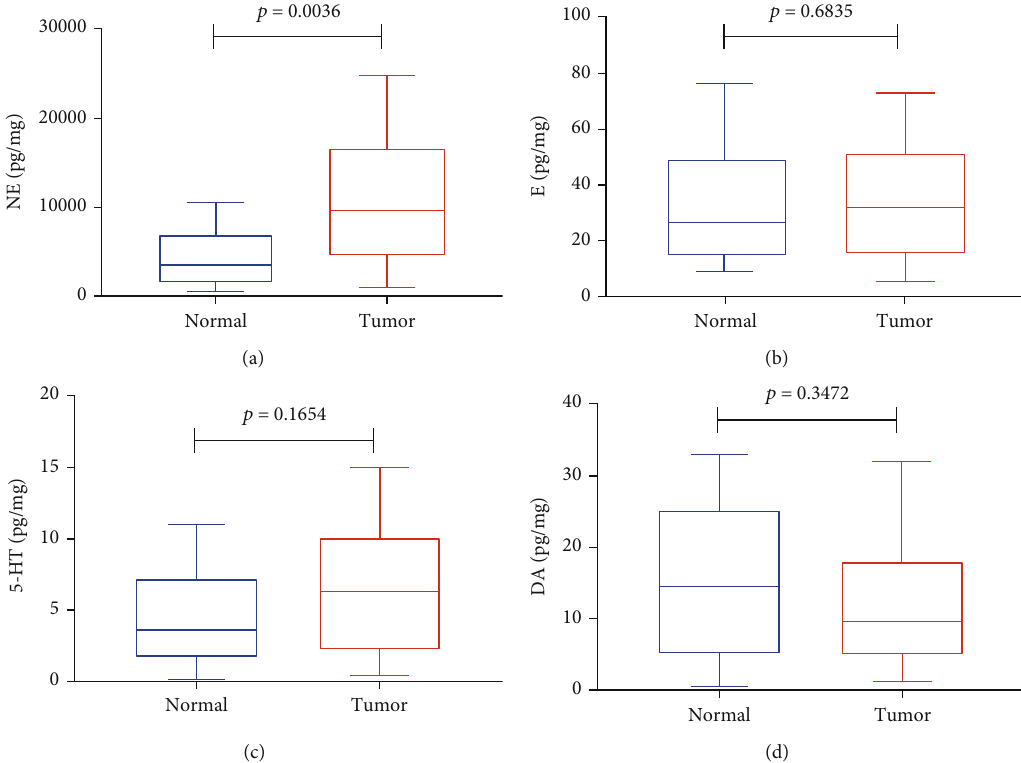
Figure 1: NE is more highly expressed in gastric tumor tissue than in normal tissue, while the other monoamine neurotransmitters E 5-HT and DA are not signi fi cantly di ff